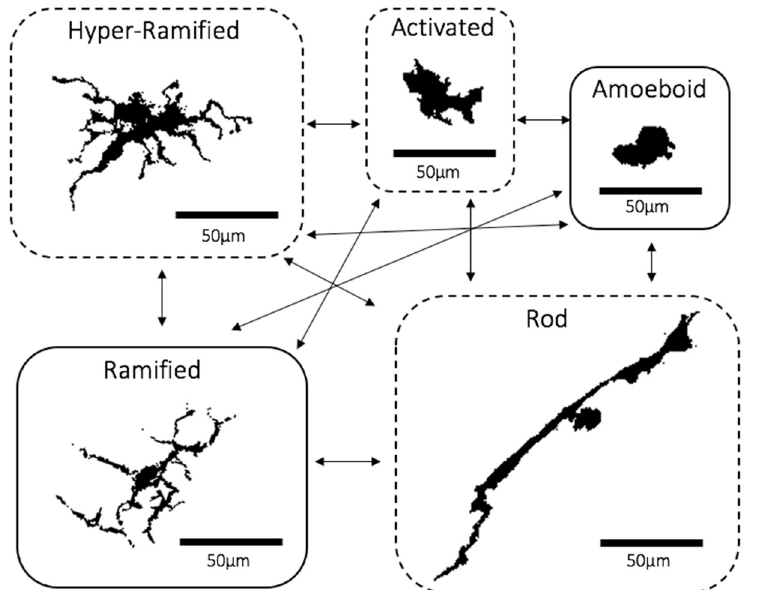
Figure 1. Microglia Morphotypes. A diagram showing microglia morphotypes with arrows showing potential orders of morphotype modifications. Dashed boxes represent the “transitioning” microglia. Microglia are from whole-mount retinal images of iba-1-stained C57BL6 mouse (28 months old) retinal microglia. Scale bar = 50 µ m. Images were obtained from the Cordeiro Laboratory following similar protocols mentioned in Davis et al. [24].